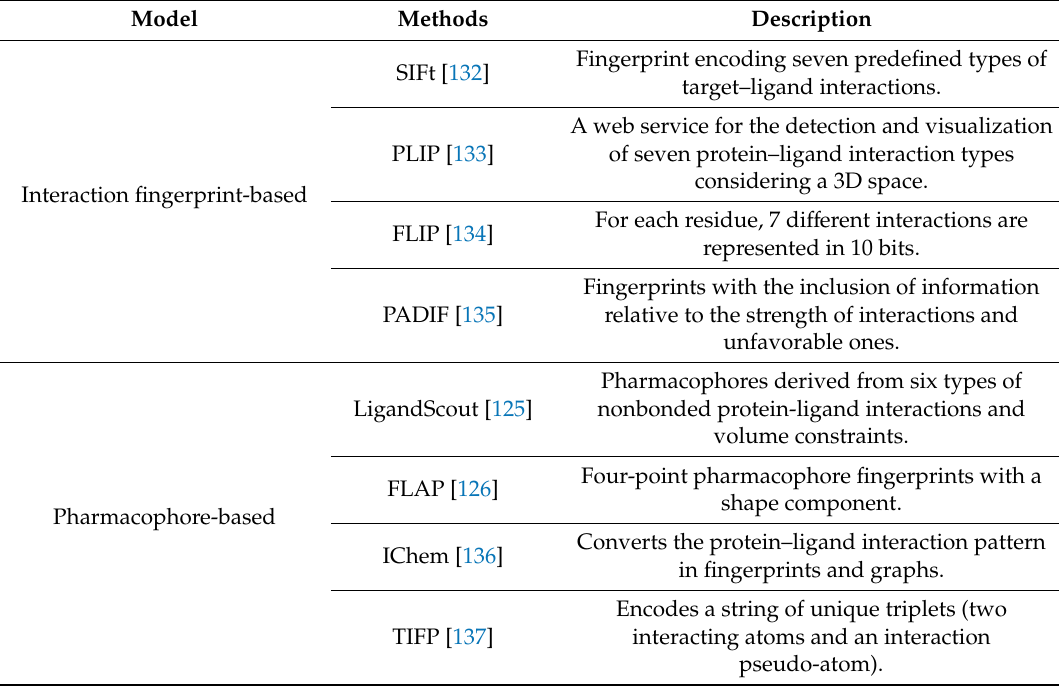
Table 2. Selection of pseudoquery methods categorized by the underlying protein-interaction